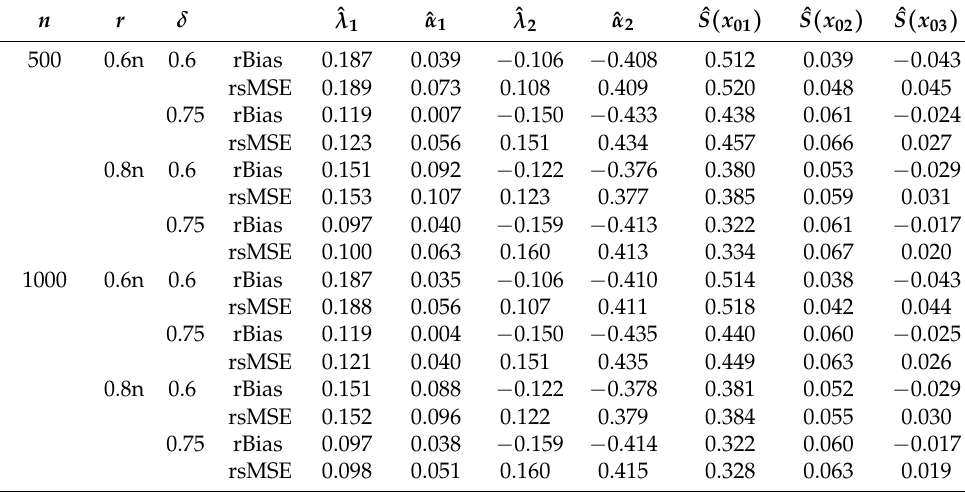
Table 1. Mixture Weibull distributions model with λ 1 = 1.5, α 1 = 2, λ 2 = 2, α 2 = 4 and